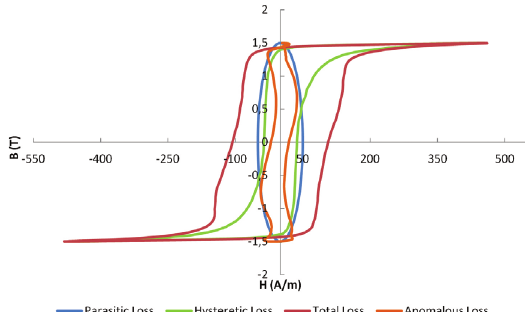
Figure 4. Loss separation for NO samples annealed for 8 hours at 850 °C with final grain size 62 µ m using peak induction 1.5 T and frequency 60 Hz.